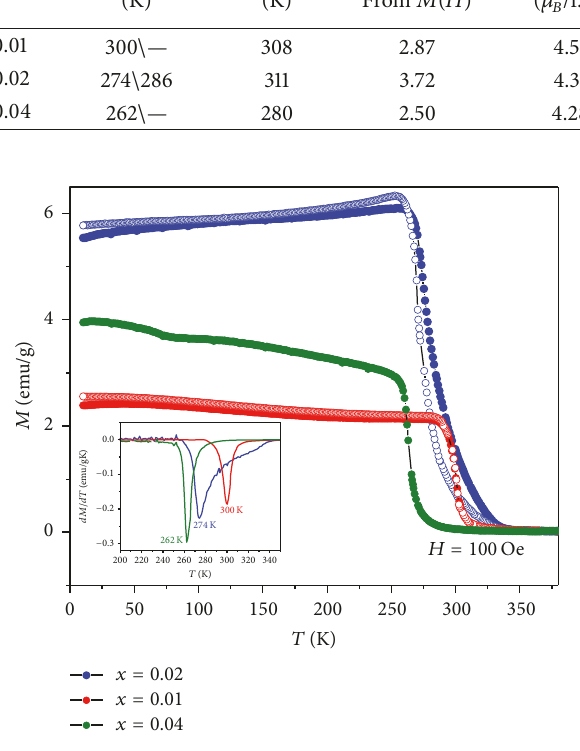
Figure 3: The temperature dependence of the magnetization 𝑀(𝑇) forMnCo 1−𝑥 Zr 𝑥 Gewith0.01 ≤ 𝑥 ≤ 0.04onheatingandcoolinginan appliedfieldof100 Oe.Thesolidandopensymbolsrepresentheating and cooling cycles, respectively. Inset: 𝑑𝑀/𝑑𝑇 versus 𝑇 curves on heating.